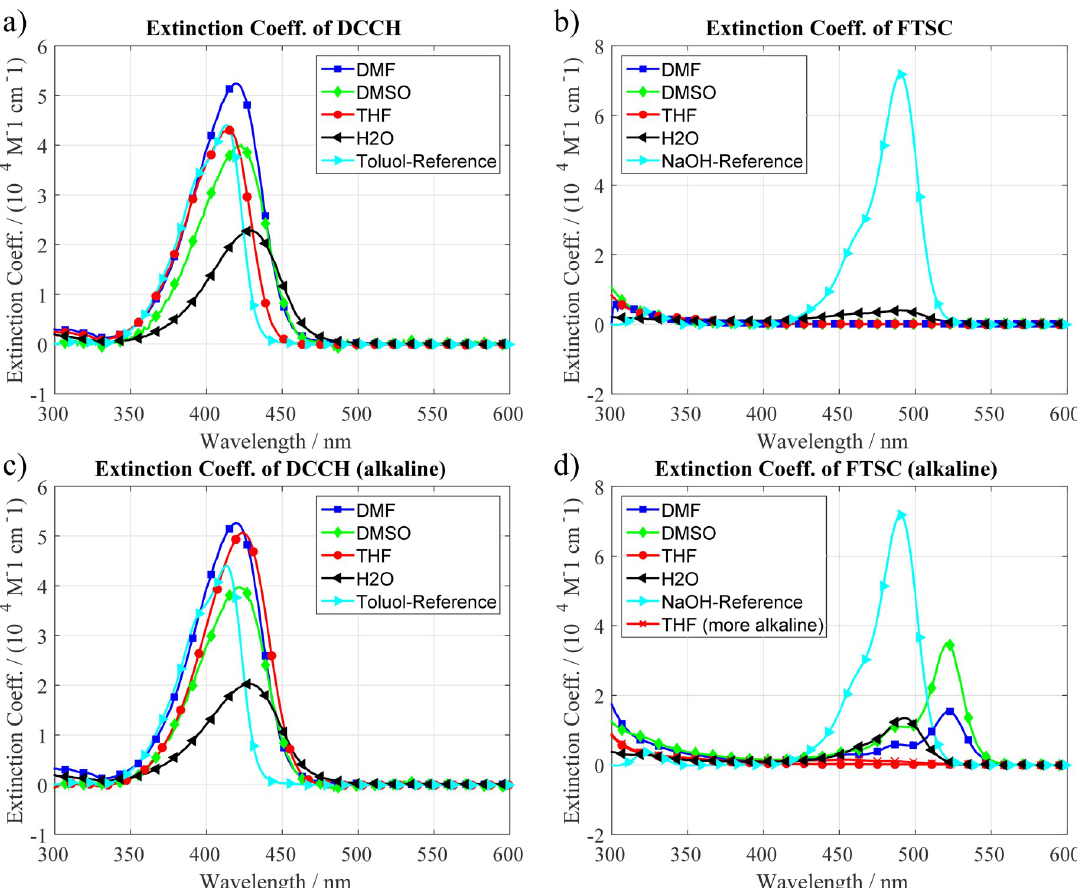
Fig 1. Molar attenuation coefficient of DCCH and FTSC at different pH conditions and in various solvents. a,b) Attenuation Coefficient of DCCH. The coefficients vary up to a factor of approx. 2.5 in the various solvents but do not show much change due to pH except for THF. The Toluol labeled sample represents the measurement of the reference molecule Coumarin 30 for the quantum yield (QY) measurements. c,d) Attenuation coefficient of FTSC. NaOH is the measurement of Fluorescein Sodium Salt needed as a reference for the QY of FTSC. c) One can see that the absorbance of FTSC is almost fully quenched in DMF, DMSO and THF in the visible range. In H 2 O the performance is a little better. d) Going to alkaline conditions increases the attenuation coefficient in most solvents.